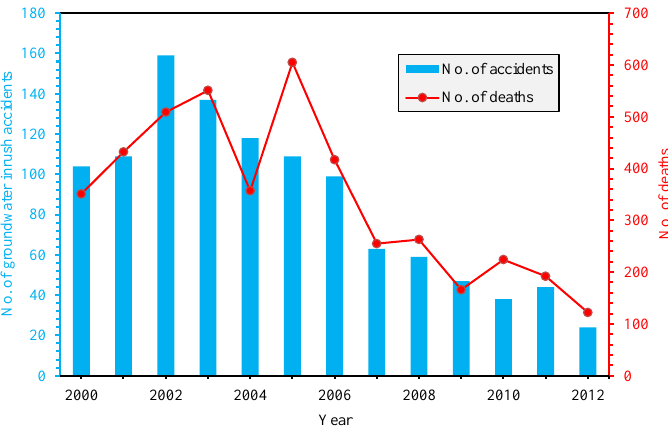
Figure 1. Statistics on mine groundwater inrush accidents (2000 – 2012).